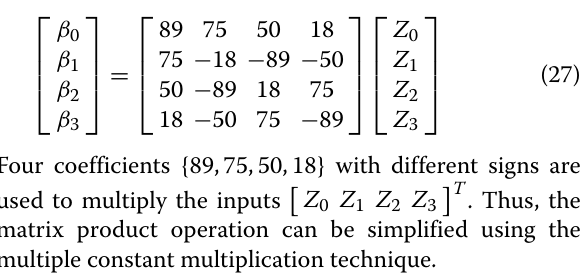
ware resources. The matrix product of the PEO4